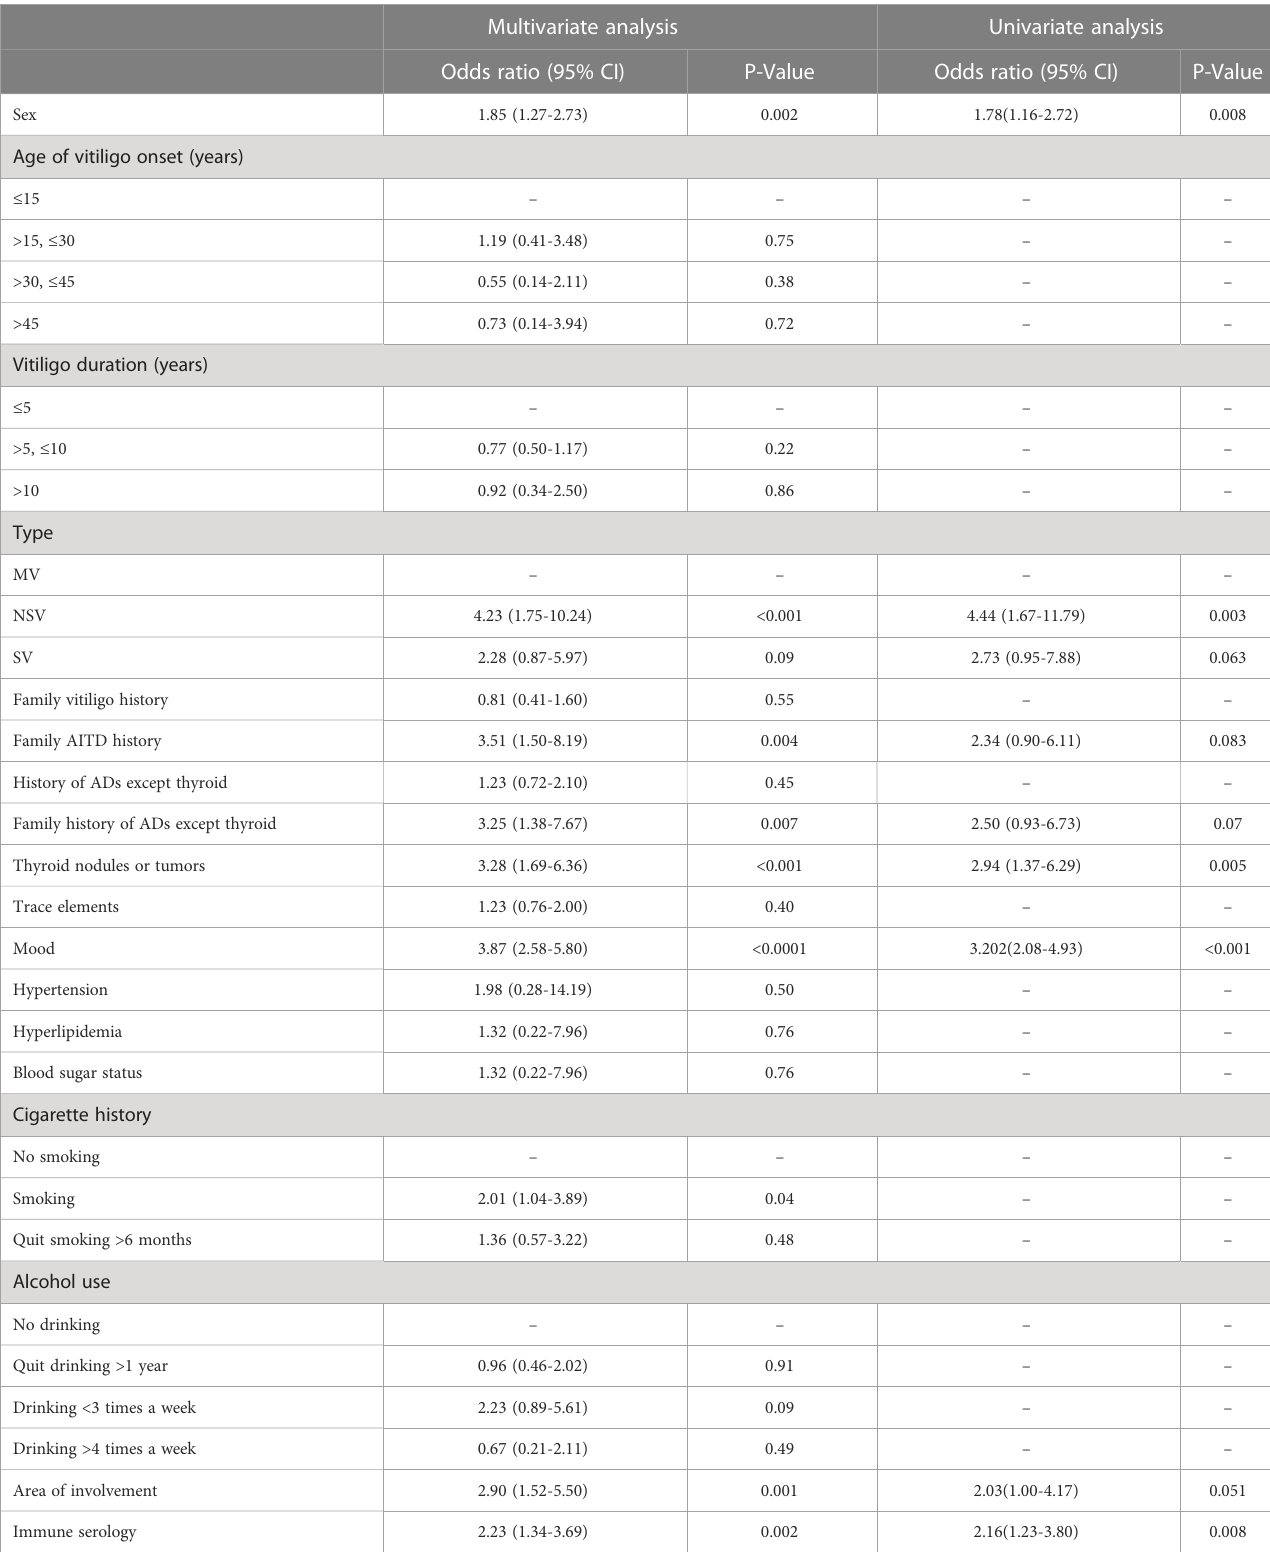
TABLE 2 Univariate and multivariate logistic regression analyses in autoimmune thyroid